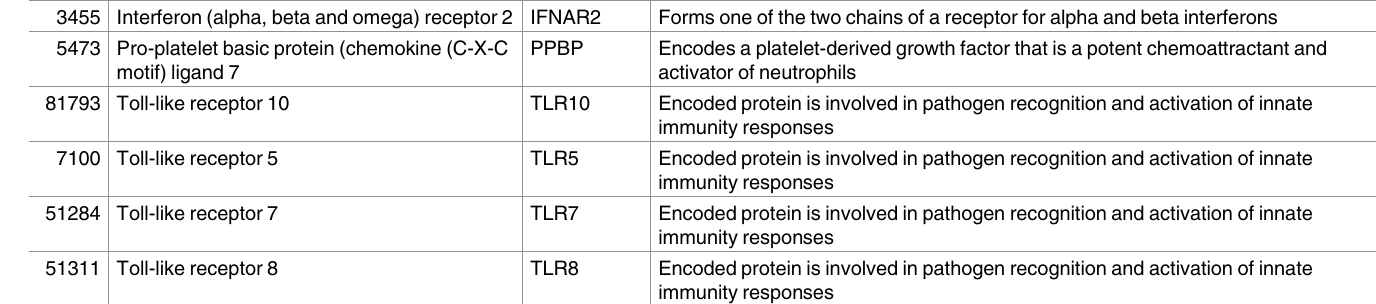
3455 Interferon (alpha, beta and omega) receptor 2 IFNAR2